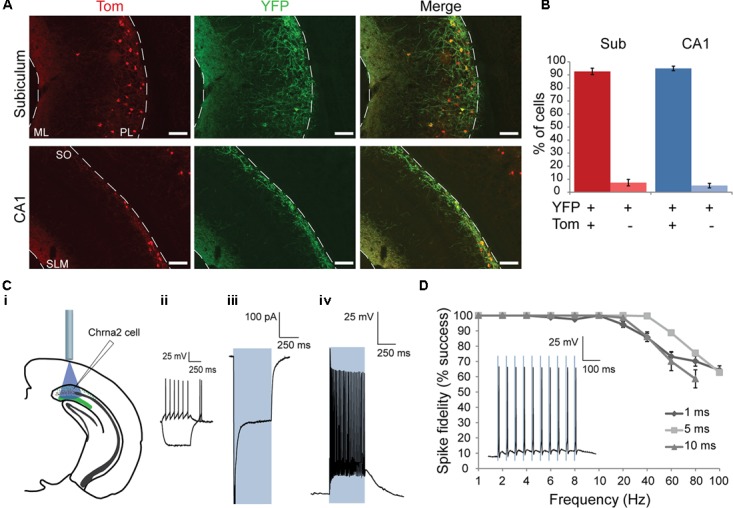
Anatomical and electrophysiological characterization of ChETA-YFP expression in Chrna2 cells. (A) 10× Images from a Chrna2-Tom animal injected with AAVdj-DIO-ChETA-eYFP in CA1/subiculum. Chrna2 cells are visualized with Tom fluorescence in red. ChETA-expressing cells are visualized with YFP fluorescence in green. Co-expressing cells are shown in yellow. Top: subiculum. Bottom: CA1. ML, molecular layer; PL, polymorphic layer; SLM, stratum lacunosum-moleculare; SO, stratum oriens. Scale bar = 100 μm. (B) Mean proportion of YFP+ cells that were Tom+ or Tom– in subiculum (red) and CA1 (blue). Animal: n = 3. Cells: subiculum, n = 522; CA1, n = 308. (Ci–Civ) Patch clamp recordings from a representative subiculum Chrna2 cell expressing ChETA. (Ci) Diagram depicting optogenetic patch clamp experiment. (Cii) Responses to depolarizing and hyperpolarizing current steps in cc. (Ciii) Mean recorded photocurrent produced by a 500 ms light pulse (blue box) in voltage clamp (vc) at a holding potential (h.p.) of –70 mV. Spike peak was truncated to expand view of plateau photocurrent. (Civ) Spiking in response to a 500 ms light pulse (blue box) in cc at an h.p. of –60 mV. (D) Mean spike fidelity for trains of 1, 5, and 10 ms light pulses at frequencies of 1–100 Hz. n = 7–9. Error bars = SEM. Inset: Spiking in response in a representative cell to an 8 Hz train of 5 ms light pulses (blue boxes) in cc at an h.p. of –60 mV.